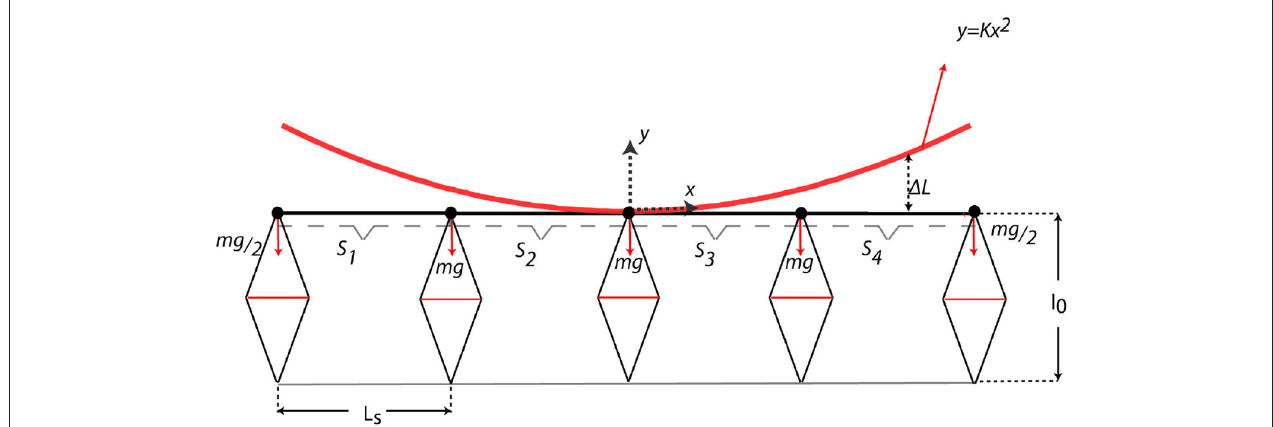
FIGURE 14 | Problem Description for the deployable support structure.